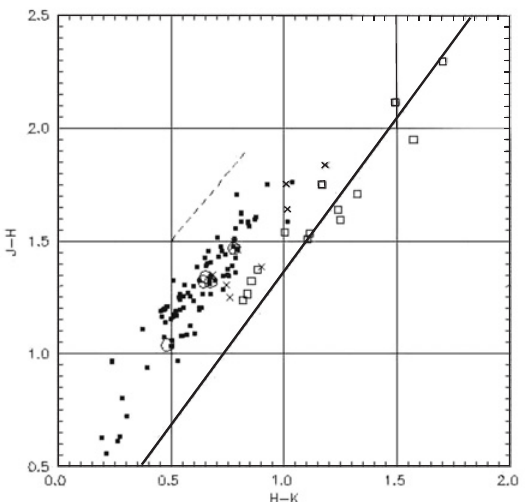
Fig. 1. The J − H , H − K diagram for carbon stars in the Cygnus field; small full squares represent non-periodic or non-variable stars, large open circles represent SR variables, crosses represent Mira or SRa variables with negligible secondary variation, open squares represent LPVs with considerable secondary variation. The solid line represents the black-body line, the dotted line shows the trend of the interstellar reddening